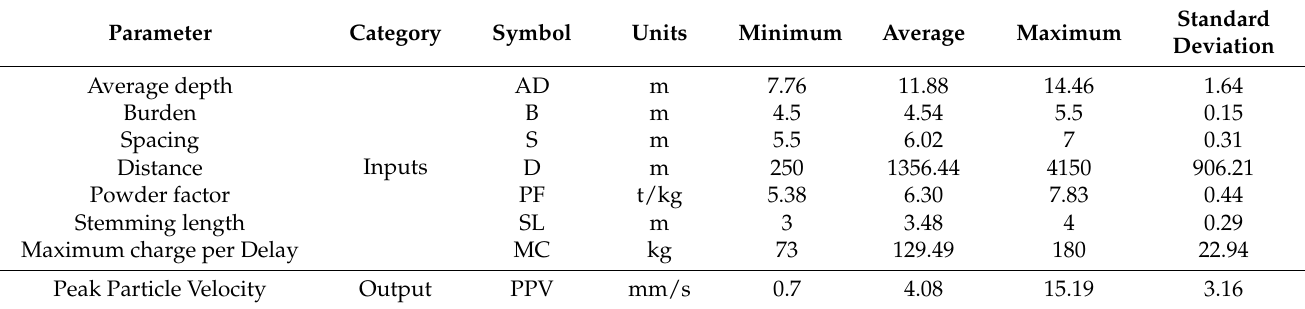
Table 4. Description of dataset parameters.